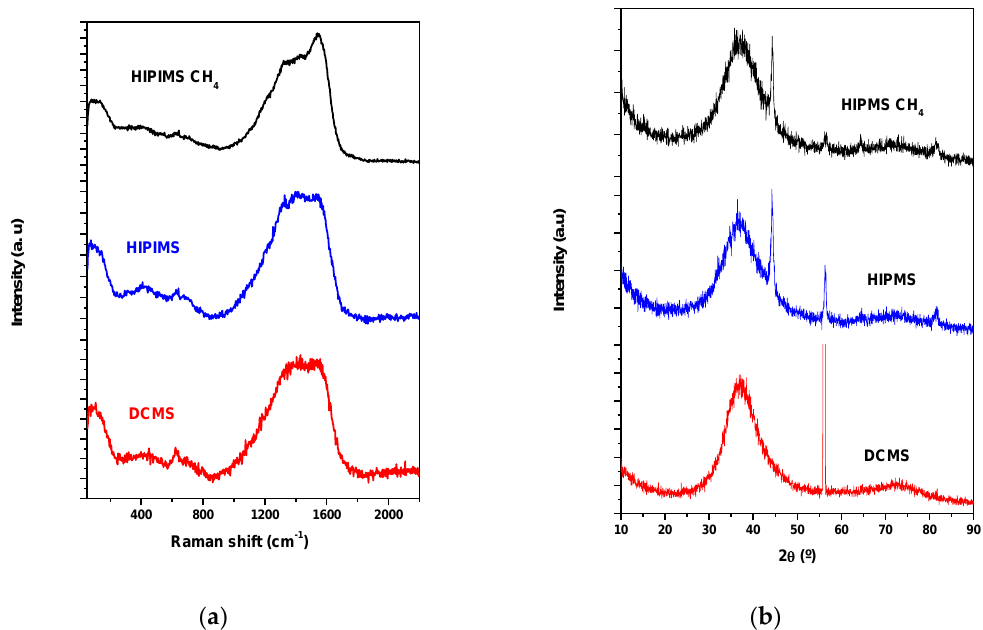
Figure 4. ( a ) Raman spectra and ( b ) X-ray diffraction patterns of the coatings. Table 2. Raman analysis of the coatings.